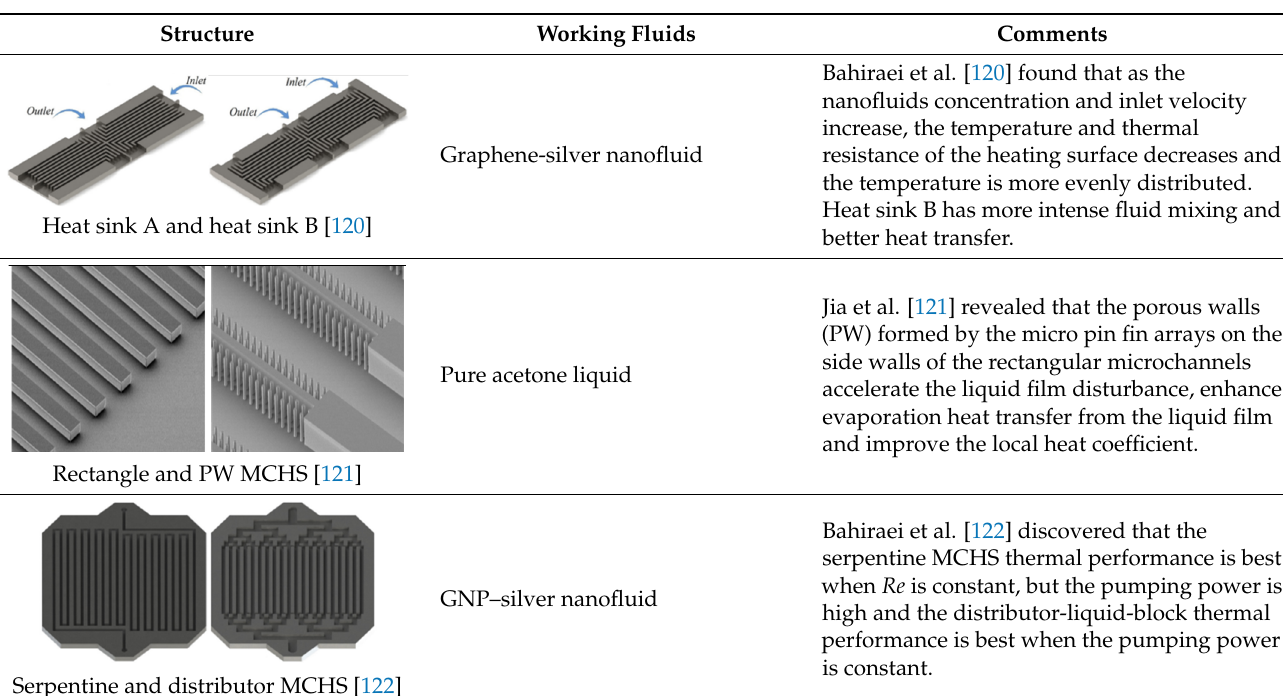
Table 6. The influence of microchannel distribution on the thermal-hydraulic performance of the